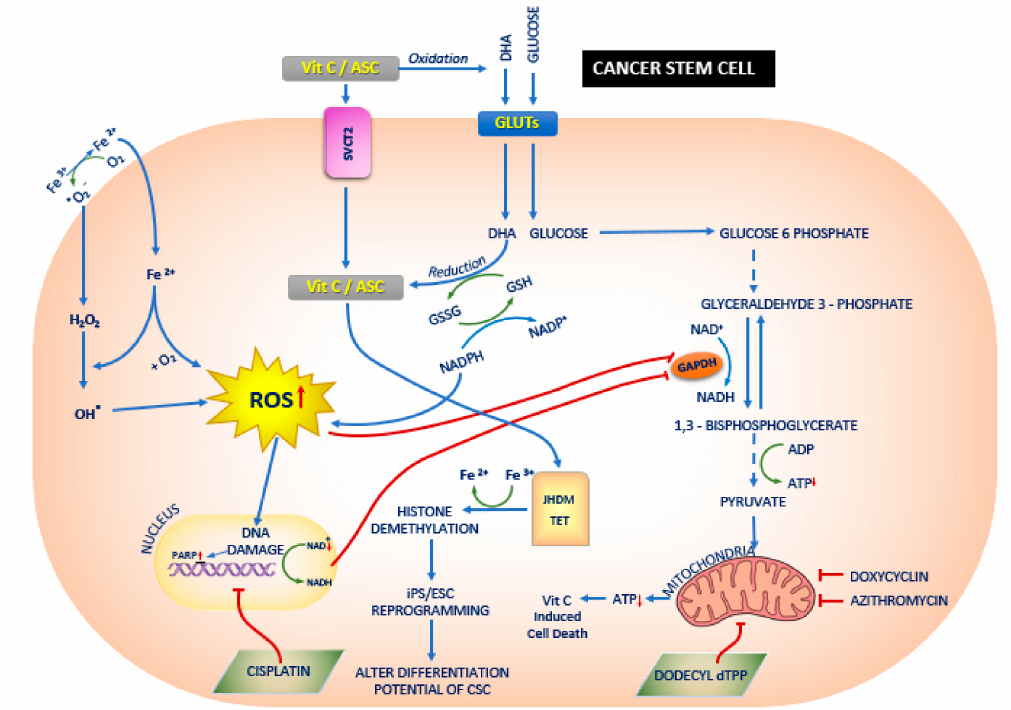
Figure 2. The e ff ect of Vitamin C (Vit.C) on cancer stem cells (CSCs). Vit.C along with the conventional cancer therapy has a synergistic e ff ect on the treatment of cancers. Vit.C enters the CSC via sodium dependent Vit.C transporter 2 (SVCT2) or glucose transporters GLUTs, and thereby alters jumonji-C domain-containing histone demethylases (JHDM) / Ten eleven translocation (TET) and reactive